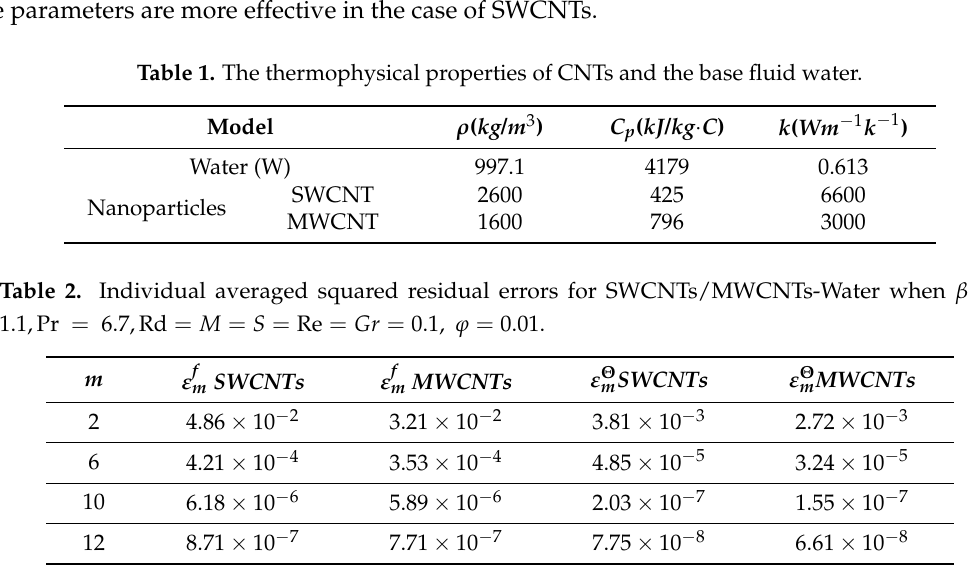
Table 3. Exhibits the Numerical values for skin friction coefficient for different physical parameters